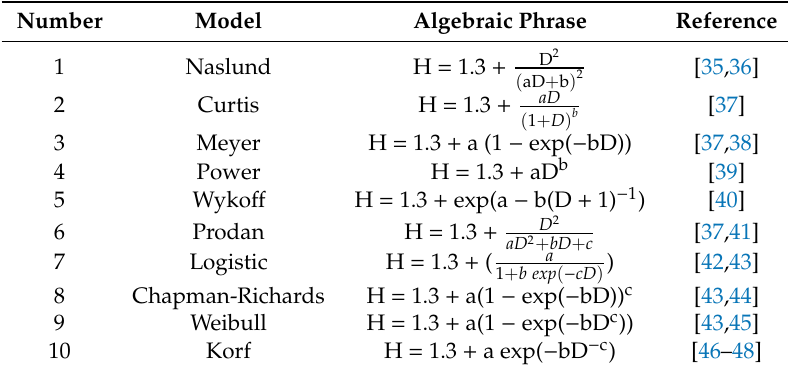
Table 4. Nonlinear empirical diameter and height models.